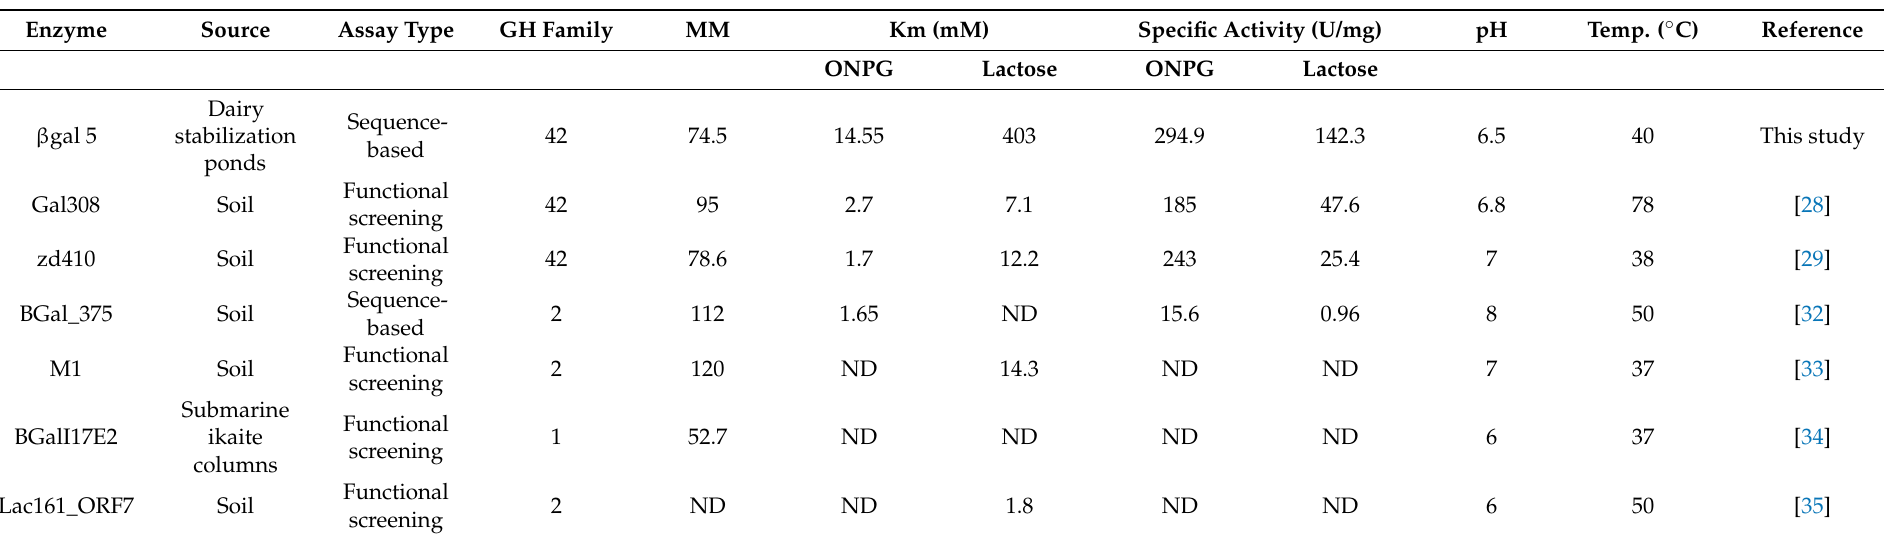
Lac161_ORF7 Soil